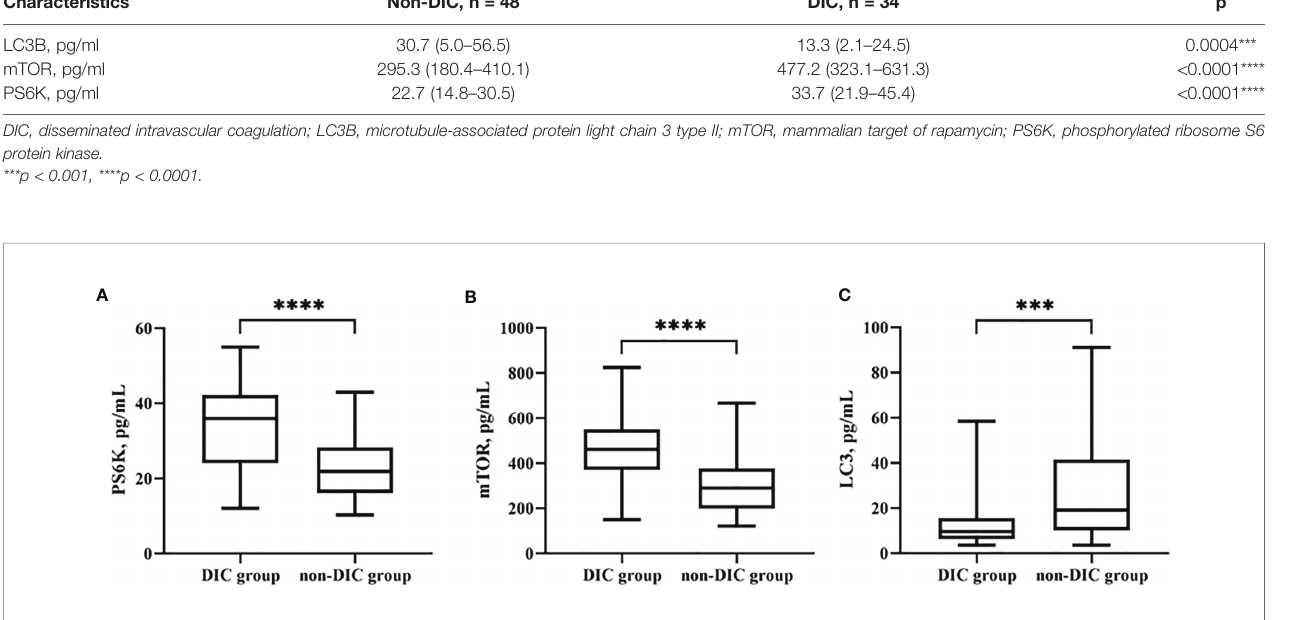
FIGURE 5 | Comparison of autophagy biomarkers levels, including PS6K (A) , mTOR (B) , and LC3B (C) in groups of patients with or without DIC. ***p < 0.001, ****p < 0.0001. DIC, disseminated intravascular